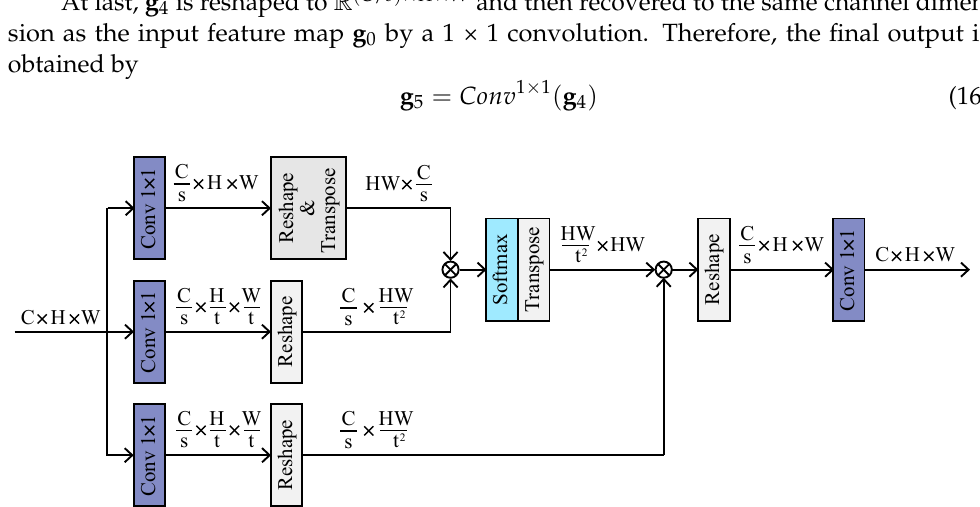
Figure 4. Dual downsampling spatial attention (DDSA)